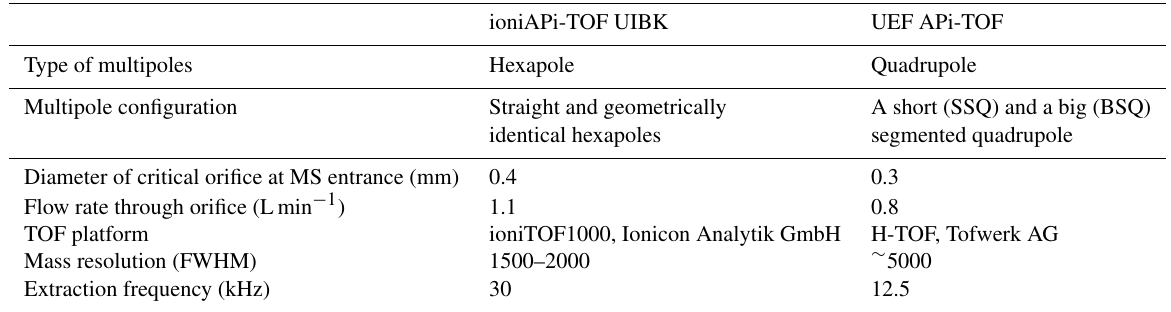
Table 3. Main technical differences of the ioniAPi-TOF UIBK compared to the UEF APi-TOF relevant for this study (Junninen et al., 2010). Mass resolution and extraction frequency are setting dependent. Shown values were used during the CLOUD 12 campaign and therefore valid for the inter-comparison in Sect. 3.3. ioniAPi-TOF UIBK UEF APi-TOF Type of multipoles Hexapole Quadrupole Multipole configuration Straight and geometrically A short (SSQ) and a big (BSQ) identical hexapoles segmented quadrupole